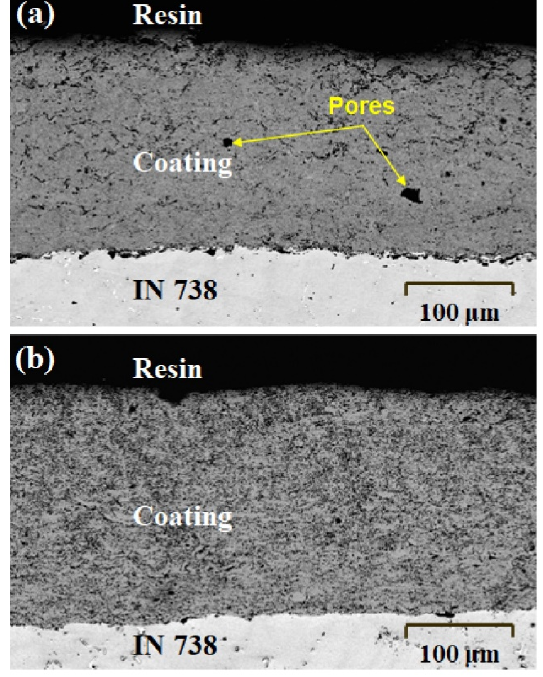
Figure 4. Cross-sectional FESEM images of ( a ) Microcrystalline AlCrFeCoNi HEA coating ( b ) nano- crystalline AlCrFeCoNi HEA